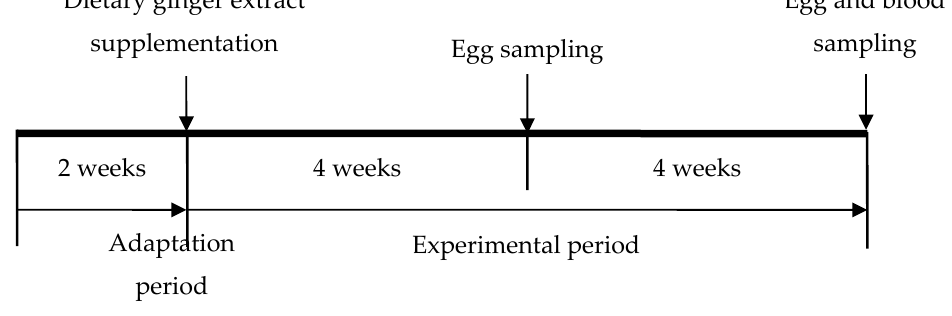
Figure 1. Scheme of experimental design. Table 1. Ingredient and nutrient composition of the basal diet (g/kg unless otherwise stated).